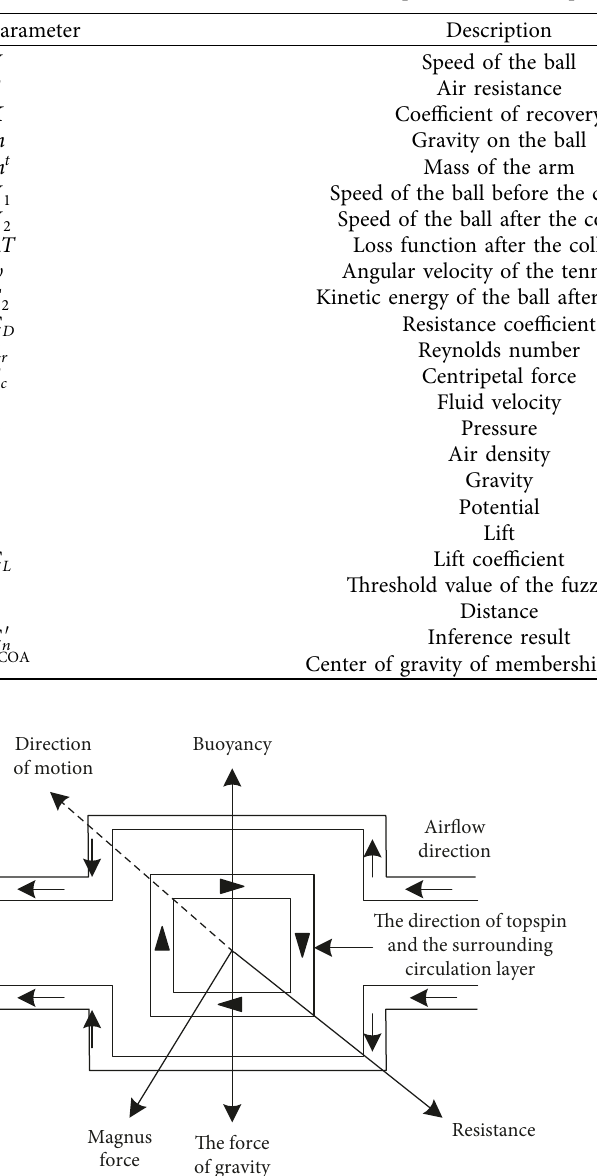
Figure 1: Aerodynamic analysis of the flight of a spinning tennis ball.